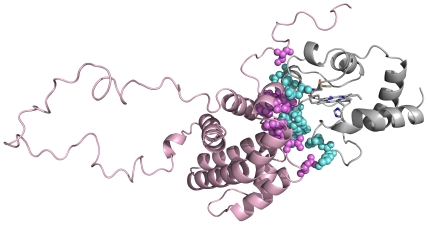
Cytochrome c−Bcl-xL adduct.Residues on cytochrome c (gray and cyan) and Bcl-xL (pink and
violet) involved in intermolecular contacts in our structural model. They
have been mapped on the lowest energy structure of our cluster of 128
conformers.